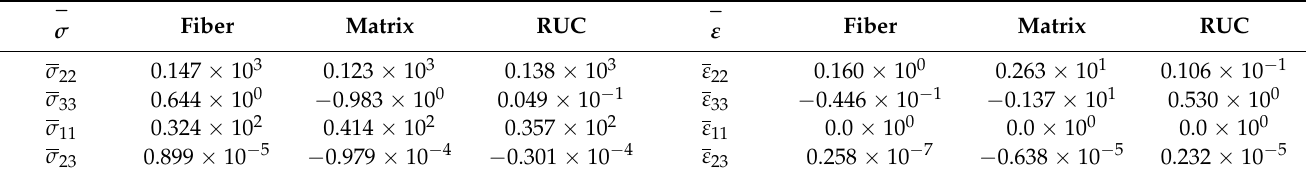
Table 5. Average values of stress and strain (Case 3).